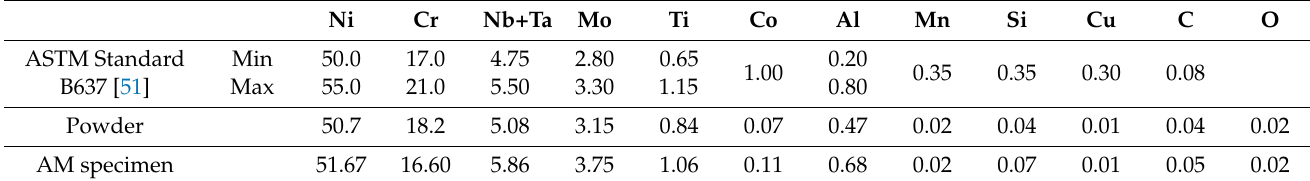
Table 3. Elemental composition (wt%) with Fe as the remainder.